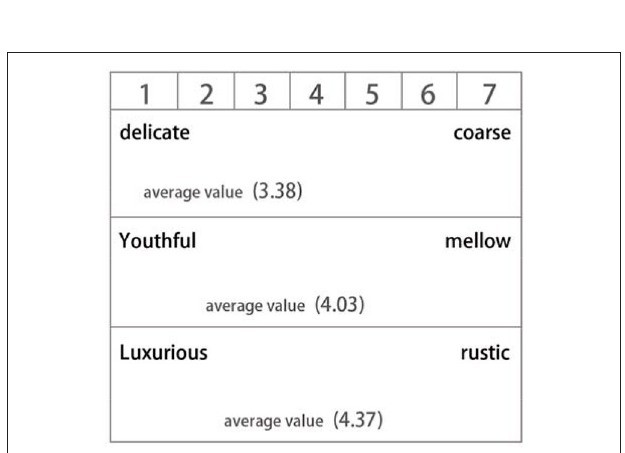
FIGURE 10 | Average value of semantics represented by three common